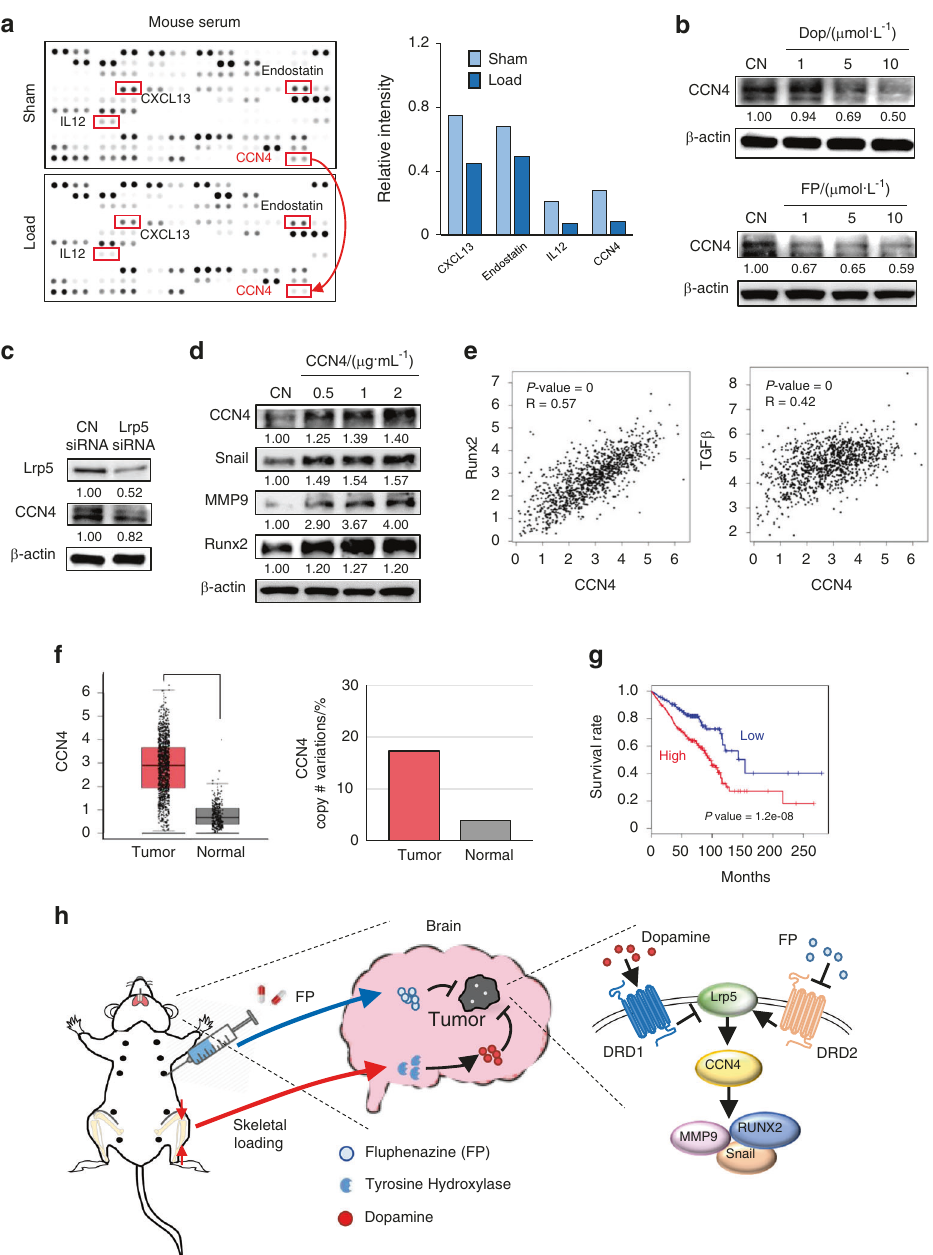
Fig. 6 Tumor-promoting role of CCN4 and its downregulation by tibial loading. Notably, load tibial loading, CN control, Dop dopamine, FP fl uphenazine. a Cytokine array analysis using the serum proteins obtained from tumor-inoculated BALB/c mice showing the downregulation of CXCL13, endostatin, IL12, and CCN4 by tibial loading. b Reduction in CCN4 level by dopamine and FP in 4T1Br cells. c Downregulation of CCN4 by the silencing of Lrp5. d Increase in Snail, MMP9, and Runx2 by the administration of recombinant CCN4 proteins in 4T1Br cells. e Transcript level correlation between CCN4/Runx2 and CCN4/TGF β in patients with breast cancer in the TCGA database. f Elevation of CCN4 transcripts in breast-cancer tissues and the increase in CCN4 gene copy number. g Reduced survival rates of patients (with breast, lung, or prostate cancer) with high levels of CCN4 transcripts. h Schematic illustration of the regulatory mechanism induced through the dopamine-Lrp5 axis. In this model, tibial loading and FP chie fl y act on DRD1 and DRD2, respectively, and they downregulate Lrp5, CCN4, MMP9, Runx2, and